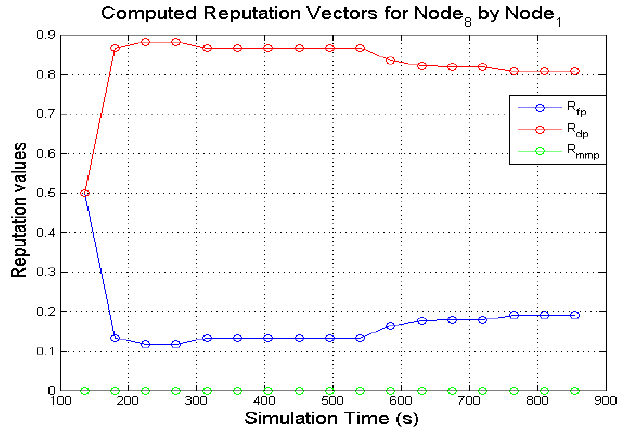
Figure 8. Reputation values for grey-hole node ( N 8 ) calculated by good node ( N 1 ).